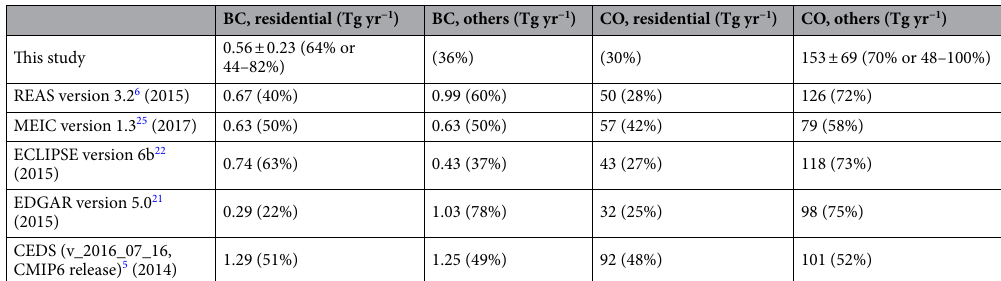
Table 1. Estimated sectoral emission fluxes of BC and CO from China in 2019, a normal year before the COVID-19 effects.